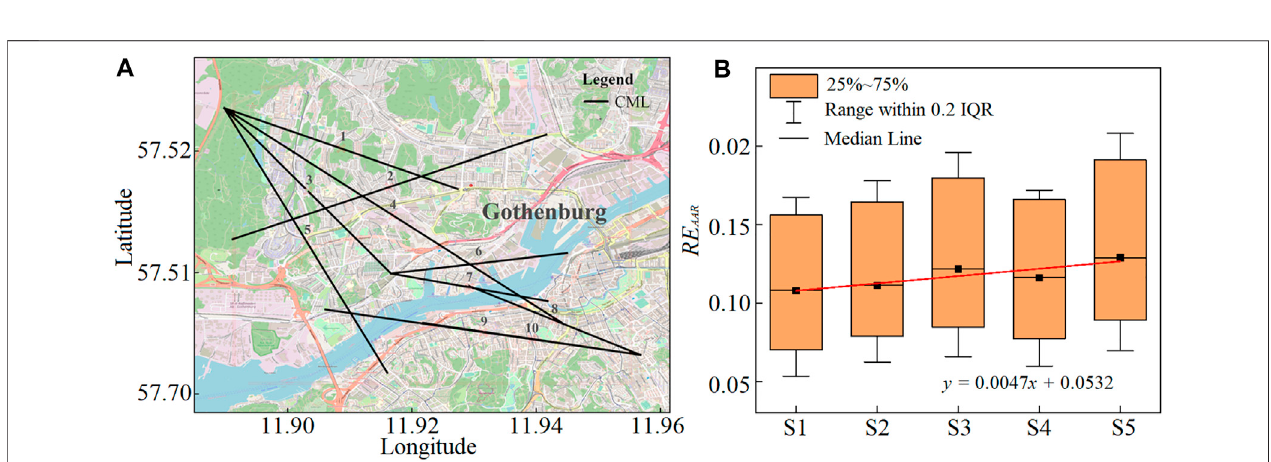
FIGURE 2 | (A) Map of commercial microwave links in Zheng et al. (2022); (B) distribution of the relative error for average areal rainfall with 100 different simulated rain fi elds, for various types of near-ground sensor networks in the same location: from CMLs only (S1) to RGs only (S5). Each CML was represented by multiple VRGs determined by GMZ preprocessing. A growing number of CMLs were replaced by RGs in groups S1-S5, such that the number of CMLs was 10, 7, 5, 3, and 0, respectively, which represents a linear model. The positive slope indicates that the more CMLs are sampling the rain fi eld, at the expense of RG, the smaller the error